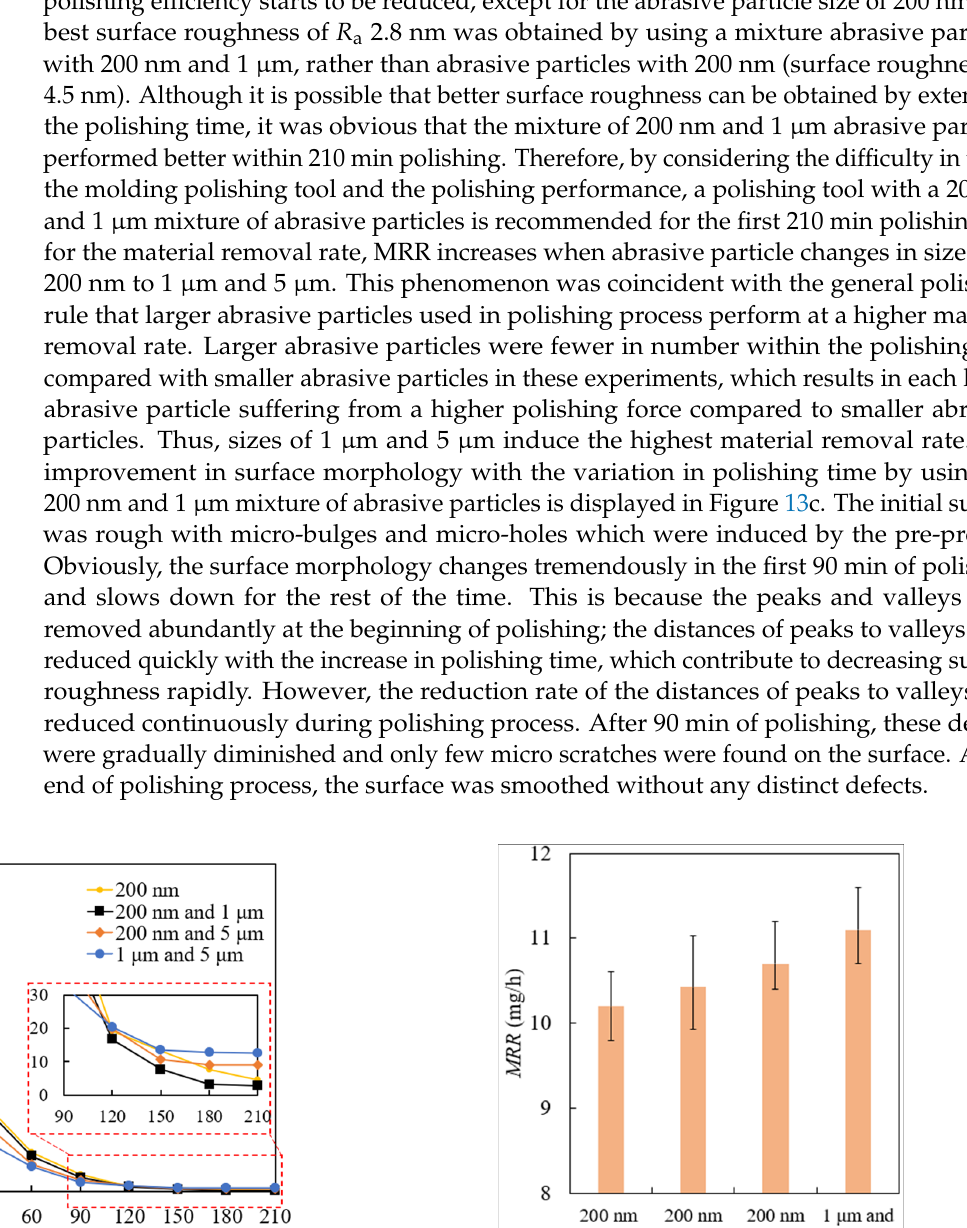
(1) External load affects the surface roughness and material removal rate the most, then the abrasive particle size, sand bond ratio, revolution speed of workpiece and polish- ing tool. The optimized polishing conditions are when the particle size is 200 nm, the sand bond ratio is 5:1, the revolution speed of workpiece is 60 r/min, the revolution speed of polishing tool is 55 r/min and external load is 132.8 kPa, when surface qual- ity was required. However, once the material removal efficiency was taken in ac- count, the appropriate polishing conditions were changed to 5 μ m in particle size, 3:1 in sand bond ratio, 60 r/min and 55 r/min in the revolution speed of workpiece and polishing tool and 132.8 kPa in external load. (2) Because the difficulty in molding polishing tool increases with the decrease in parti- cle size, although polishing tool with 200 nm particle size has the best performance on polishing, it was difficult to obtain such a polishing tool. Therefore, a polishing tool with a mixture of particles is proposed. The results demonstrated that the diffi- culty of manufacturing such a polishing tool can be reduced by mixing bigger abra- sive particles into small abrasive particles. (3) The polishing performance was investigated with different polishing tools contain- ing different abrasive particle sizes. The results show that the polishing tool with 200 nm and 1 μ m particle size performs best in the first 210 min of polishing. However, the polishing tool with 200 nm has the tendency to obtain better surface roughness by extending the polishing time.